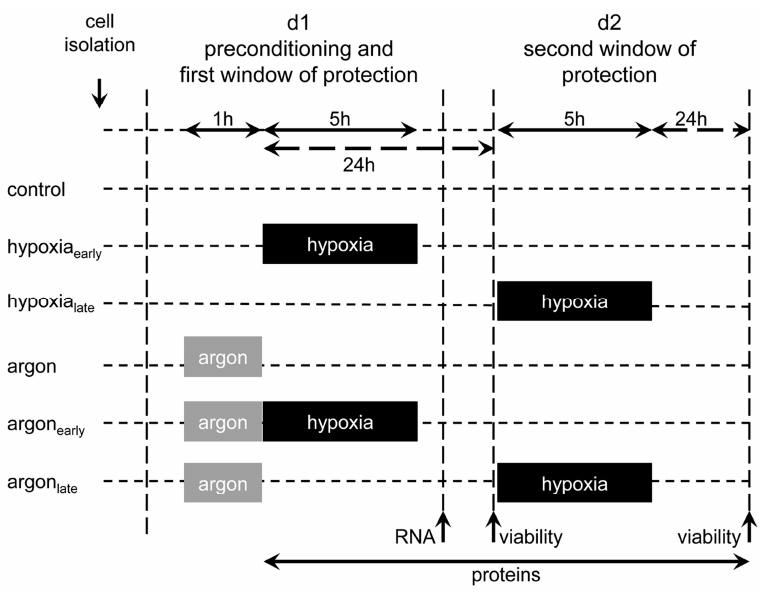
Figure 6. Experimental set-up. Isolated rat heart cells, pure cardiomyocytes, and fibroblasts were subjected either to 50% argon (50% Ar, 24% N 2 , 21% O 2 , 5% CO 2 ) or room air (74% N 2 , 21% O 2 , 5%